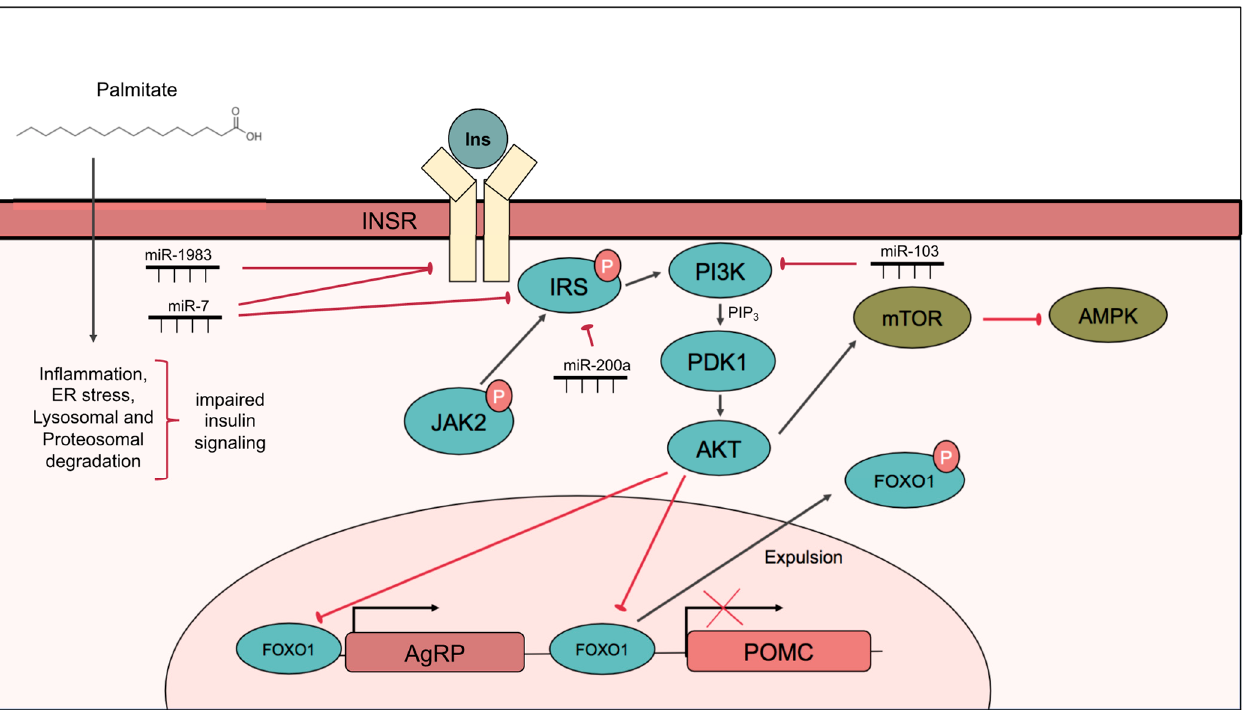
Figure 1. Hypothalamic insulin signaling. Insulin binds to insulin receptor on the cell membrane, leading to the phosphorylation of IRS, which in turn activates PI3K, to generate PIP 3 that activates Akt via PDK1. Akt phosphorylates FOXO1 leading to its expulsion from the nucleus, leading to decreased Npy and Agrp and increased Pomc expression. Akt also activates mTOR signaling. Palmitate impairs insulin signaling by inducing, inflammation, ER stress, and lysosomal and proteasomal degradation of INSR or IRS. Components of the insulin signal transduction pathway are targeted by miRNAs include. INSR is targeted by miR-1983 and miR-7, IRS is targeted by miR-7 and miR-200a, and PI3K is targeted by miR-103.